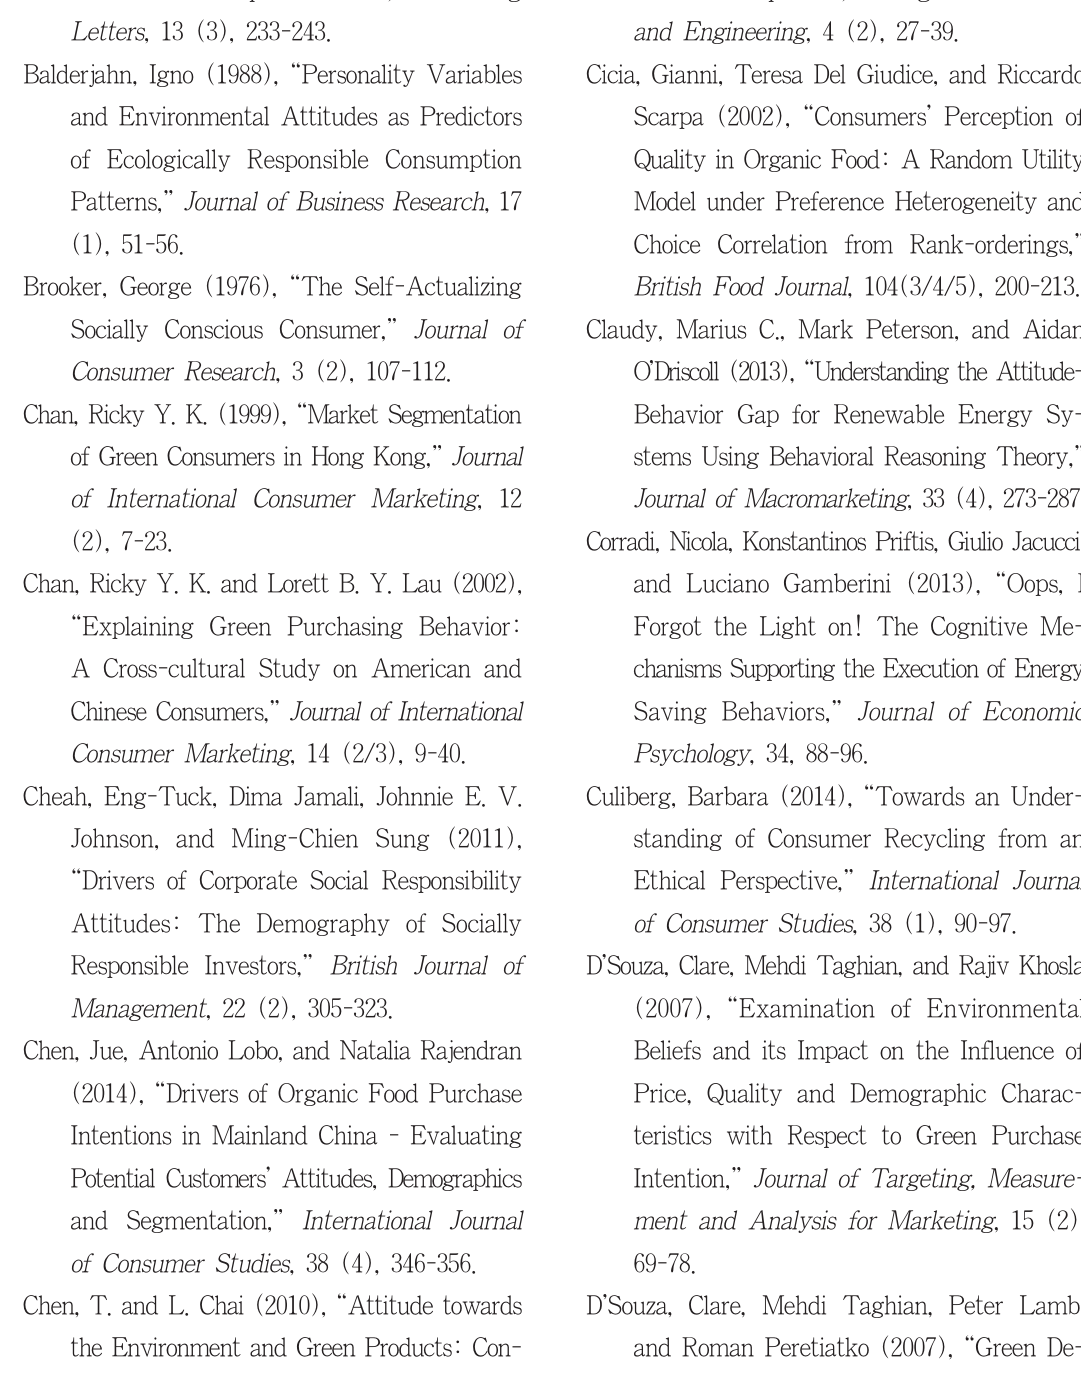
A Study on Green Consumer Segmentation Based on Socio-Demographics and Behavioral Responses: Renewing the Relationships between Socio-demographics and Green Behavior